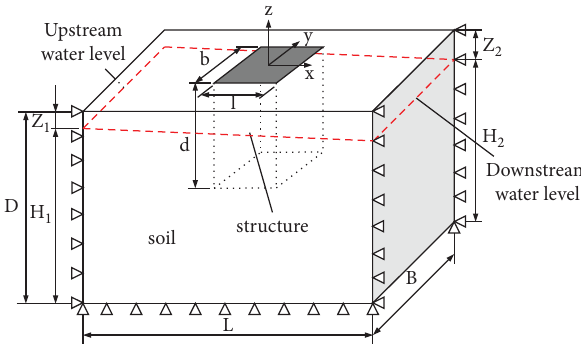
Figure 7: Schematic of the seepage